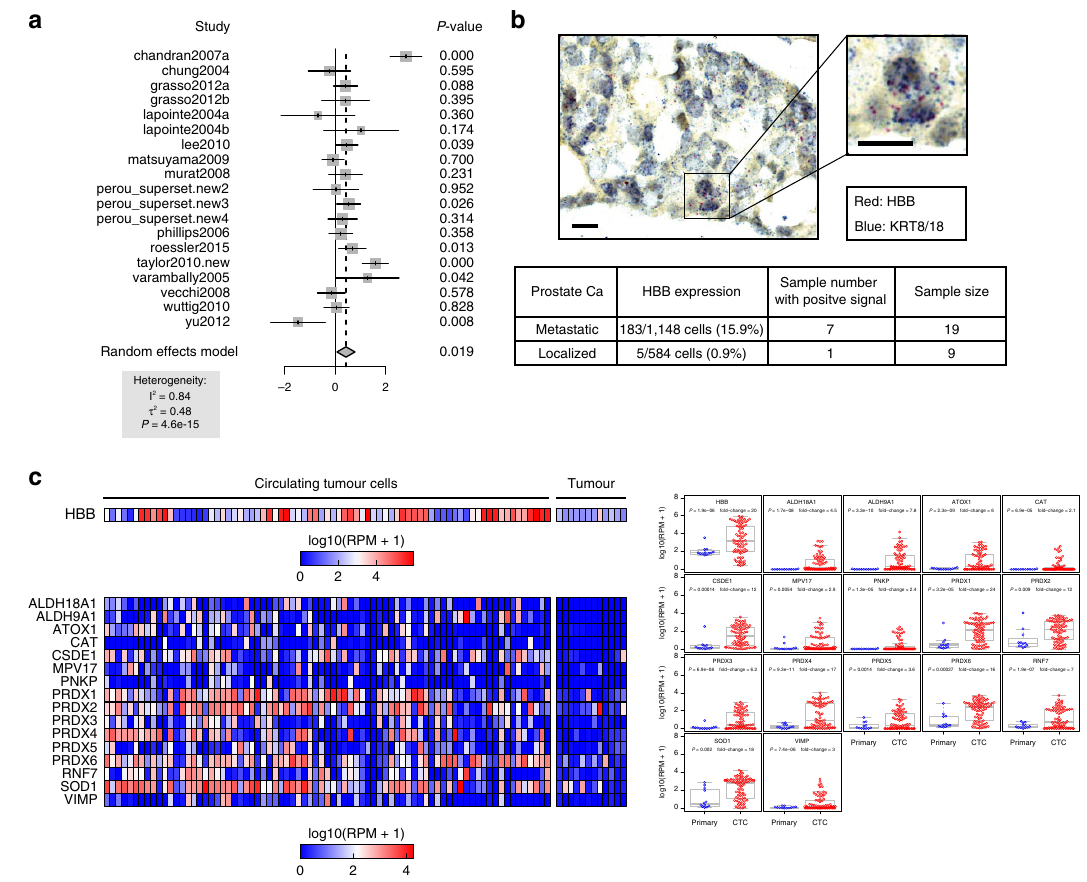
Figure 5 | Roles of HBB and other anti-oxidants in CTCs and metastasis. ( a ) Meta-analysis of HBB expression using multiple publicly available expression datasets showing increased expression of HBB in different metastatic cancers, compared with primary tumours ( P ¼ 0.019, see Methods). ( b ) Representative micrograph ( (cid:2) 40) of RNA- in situ hybridization (multimerized oligoprobes, Affymetrix) of a metastatic prostate tumour showing the expression of HBB (red) and the epithelial keratin markers KRT8/18 (blue). The table summarizes the level of HBB expression and the number of primary and metastatic prostate cancer specimens examined. Scale bar, 20 m m. ( c ) Heat map and box plots showing upregulated expression of HBB and 16 other antioxidant genes in prostate CTCs versus primary tumour. The HBB heatmap uses a different colour scale, since it has a significantly higher number of reads, compared with the other genes. Fold changes and P values for HBB and the overexpressed antioxidant genes are indicated in the box